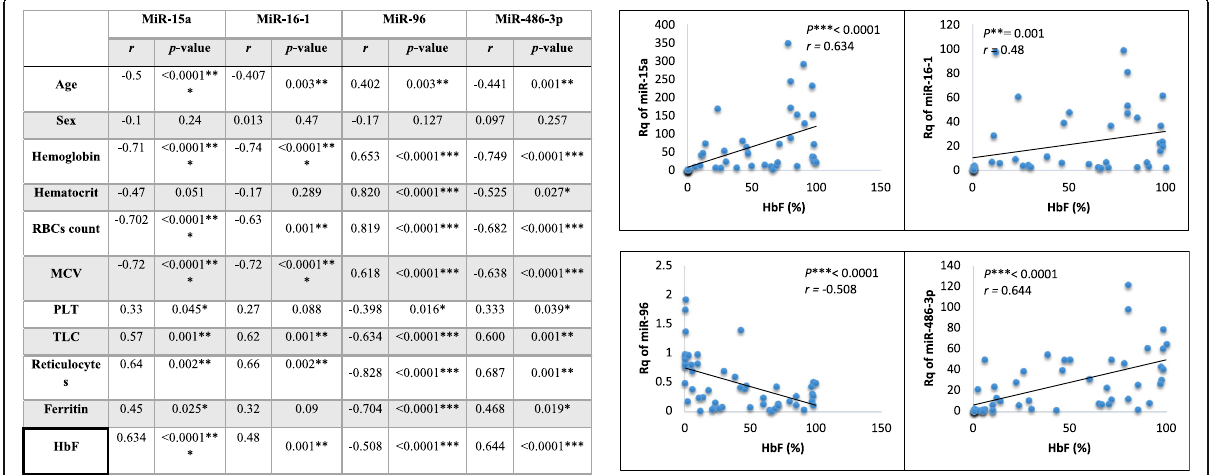
Fig. 2 Correlation coefficient between Rq of the studied miRNAs and the clinical data, correlations with HbF is shown in the